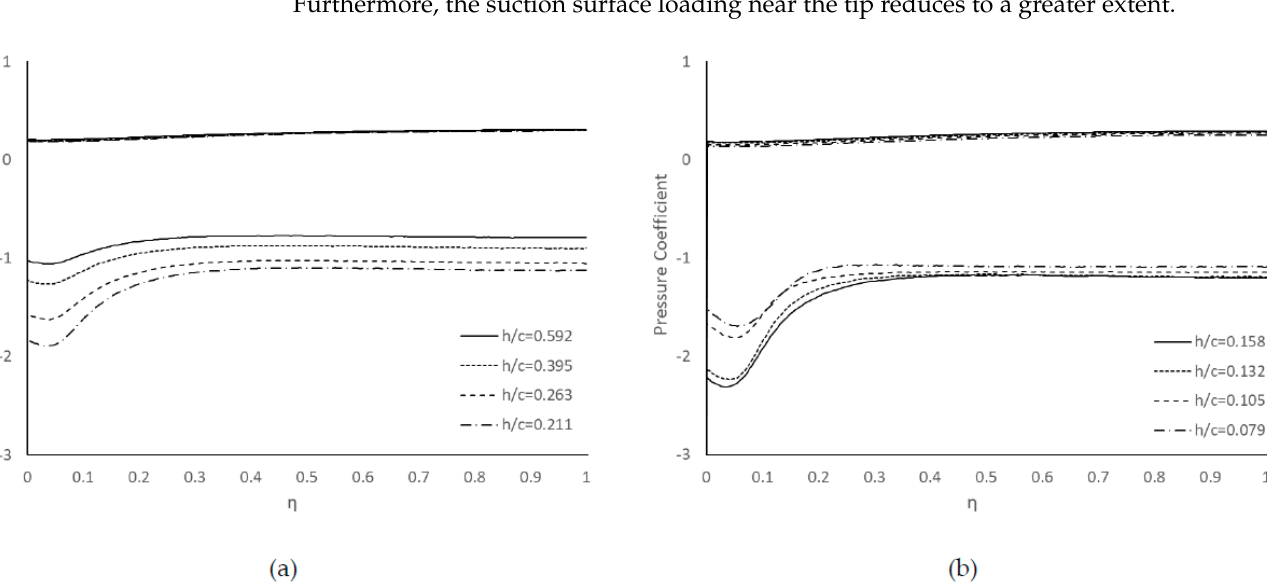
Figure 9. Spanwise surface pressure on main element: ( a ) large heights, ( b ) small heights.